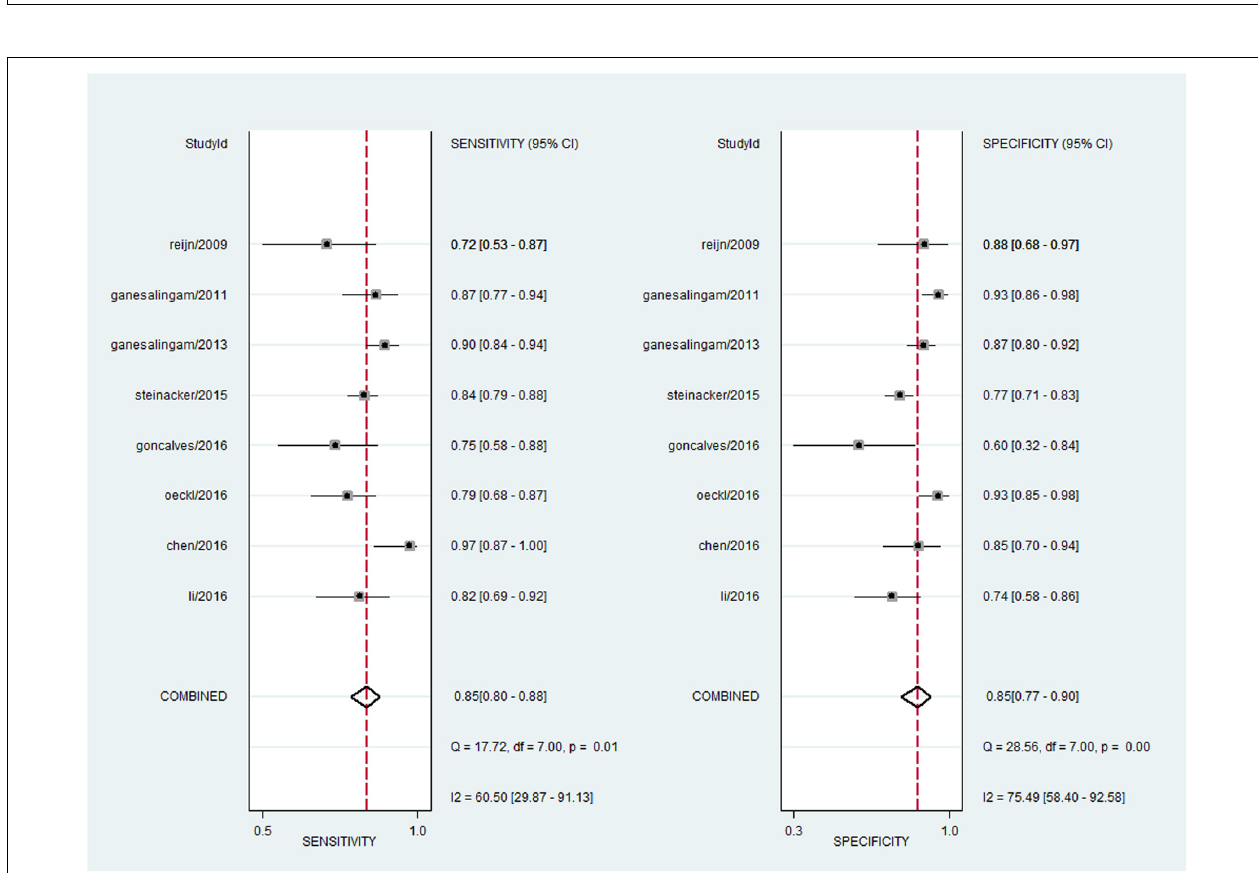
FIGURE 5 | Forest plots showing the sensitivity and specificity of pNFH in the diagnosis of MND.